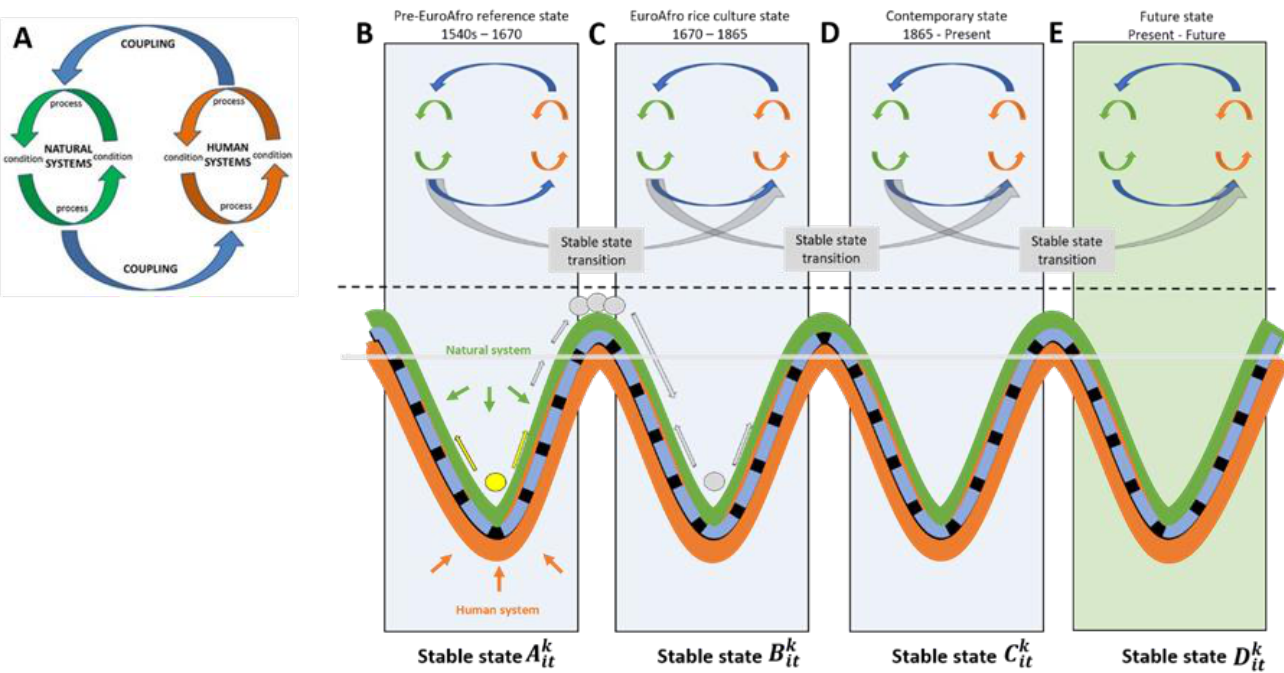
Figure 6. ( A ) Coupling of natural–human systems; ( B – E ) controls within and between coupled human and natural systems provide feedback mechanisms that maintain a stable state, but transitions to alternate stable states can occur given system disruptions (e.g., energy inputs). Coupled human–natural systems interact with one another and are controlled by parameters that influence their resilience and stability.